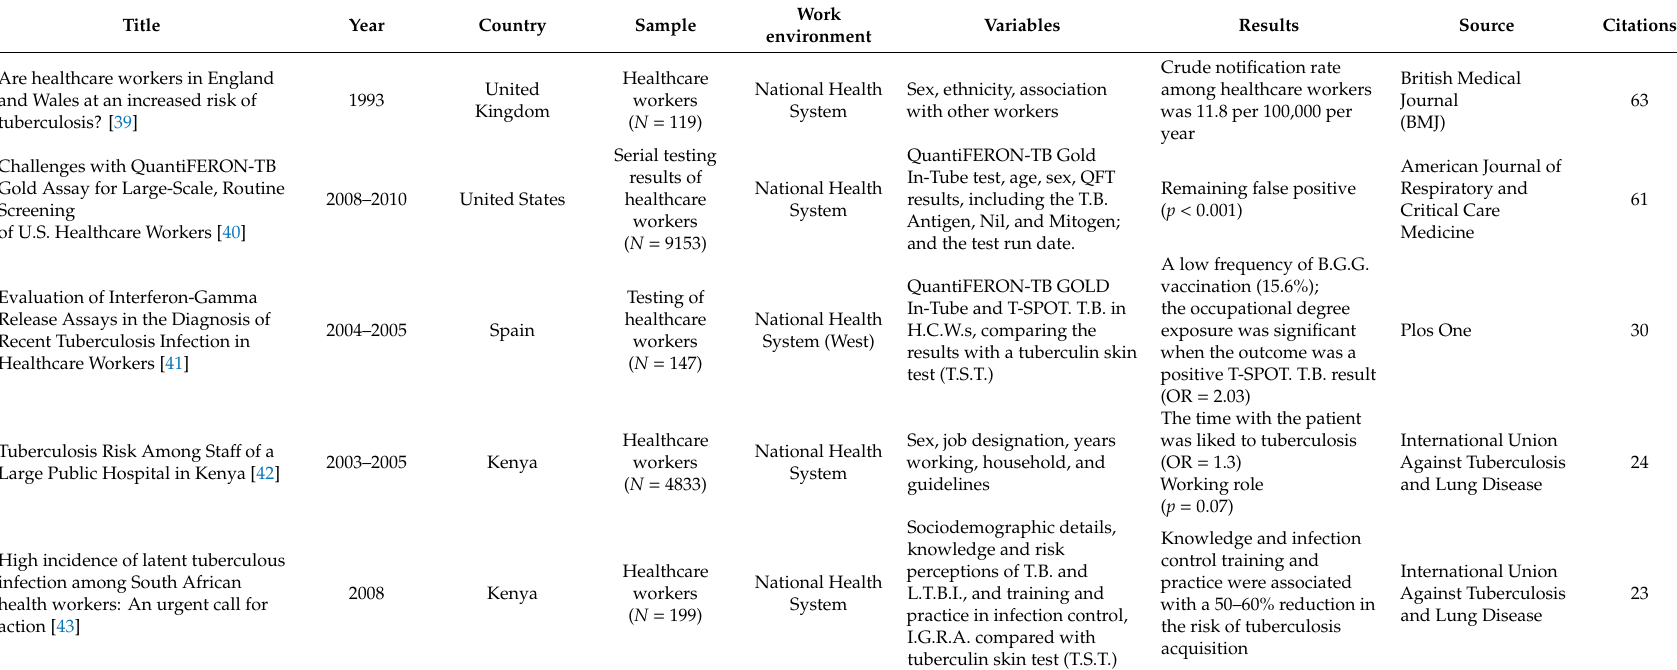
Table 5. The five most cited observational articles of the bibliometric